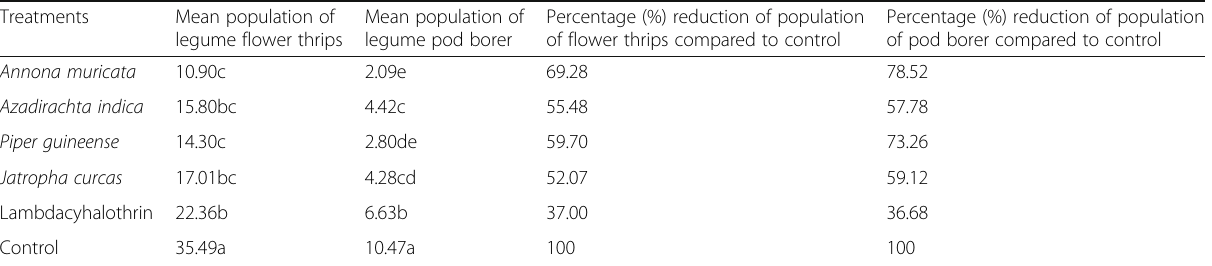
Table 1 Mean population and percentage reduction of legume flower thrips and pod borer Treatments